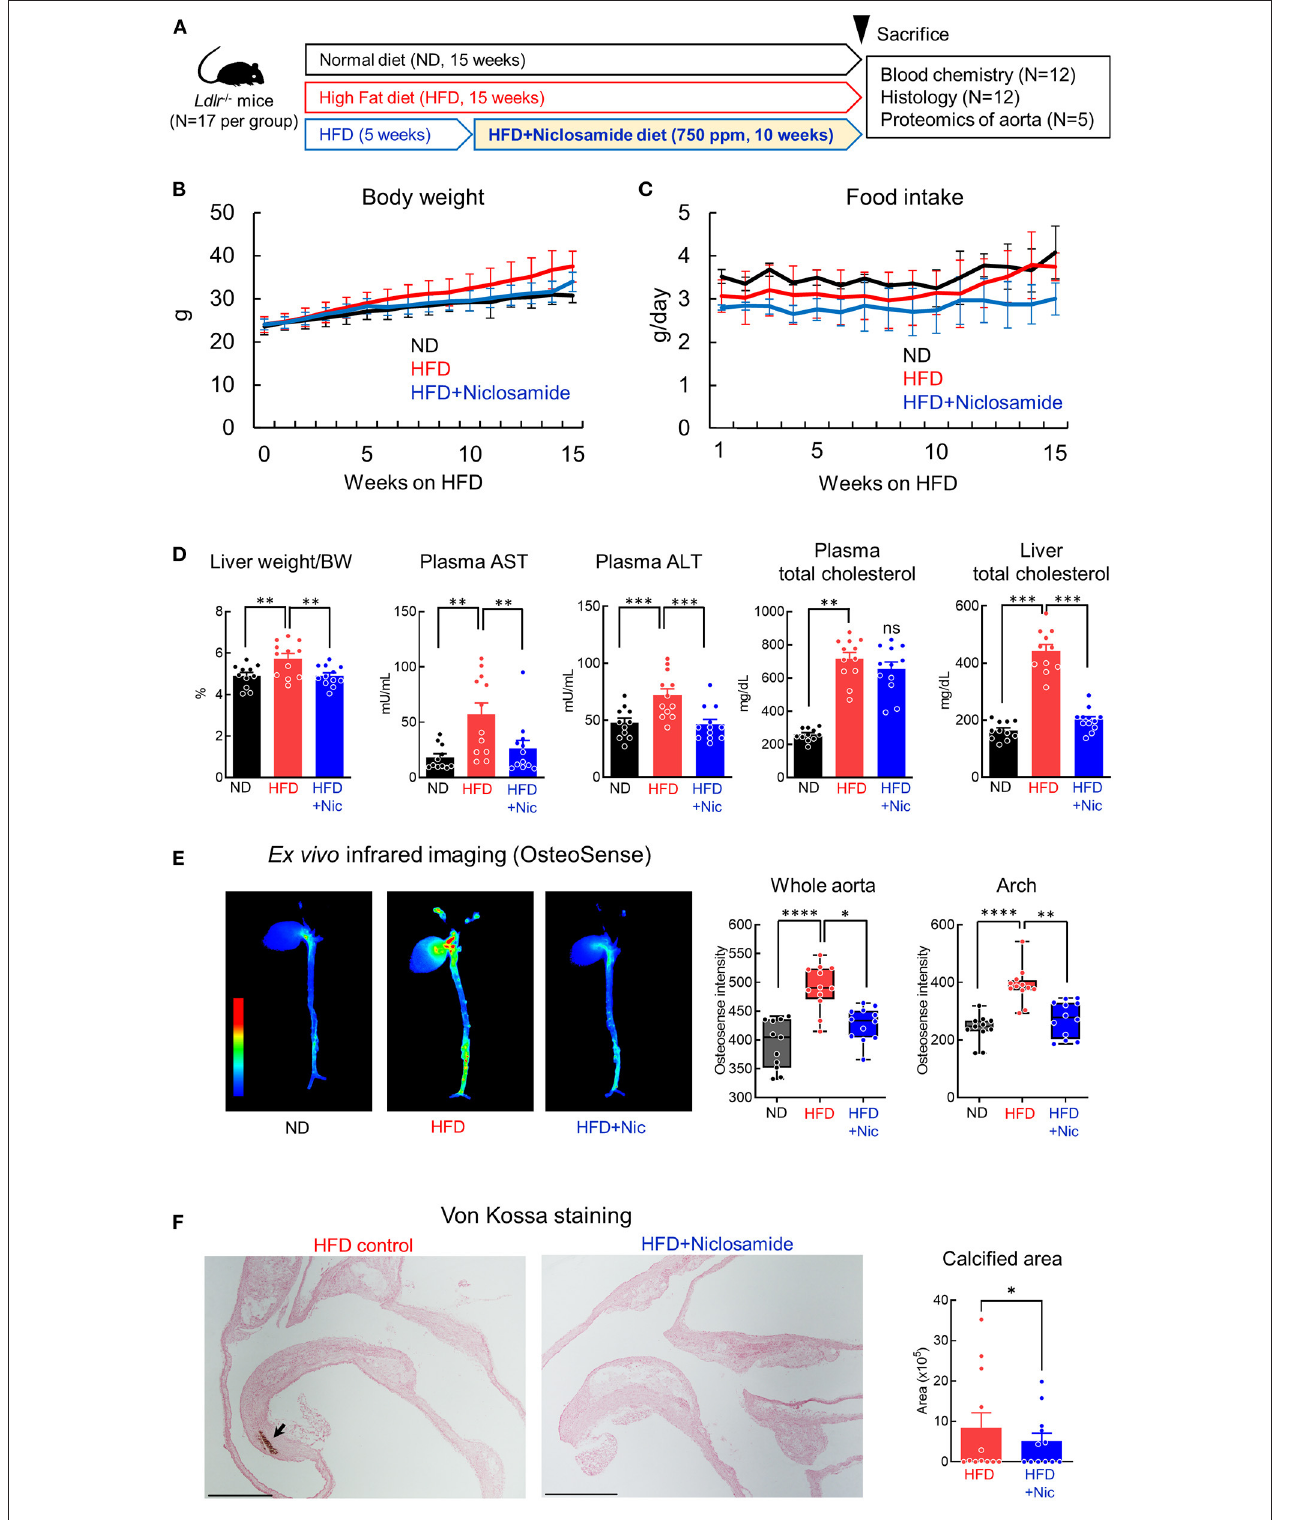
FIGURE 2 | Niclosamide decreases cardiovascular calcification in Ldlr − / − mice fed a high fat diet (HFD). (A) Schematic of the in vivo validation study using Ldlr − / − mice treated with niclosamide ( N = 12 mice per treatment group). (B) Body weight (BW) of mice fed normal diet (ND), HFD and HFD containing niclosamide